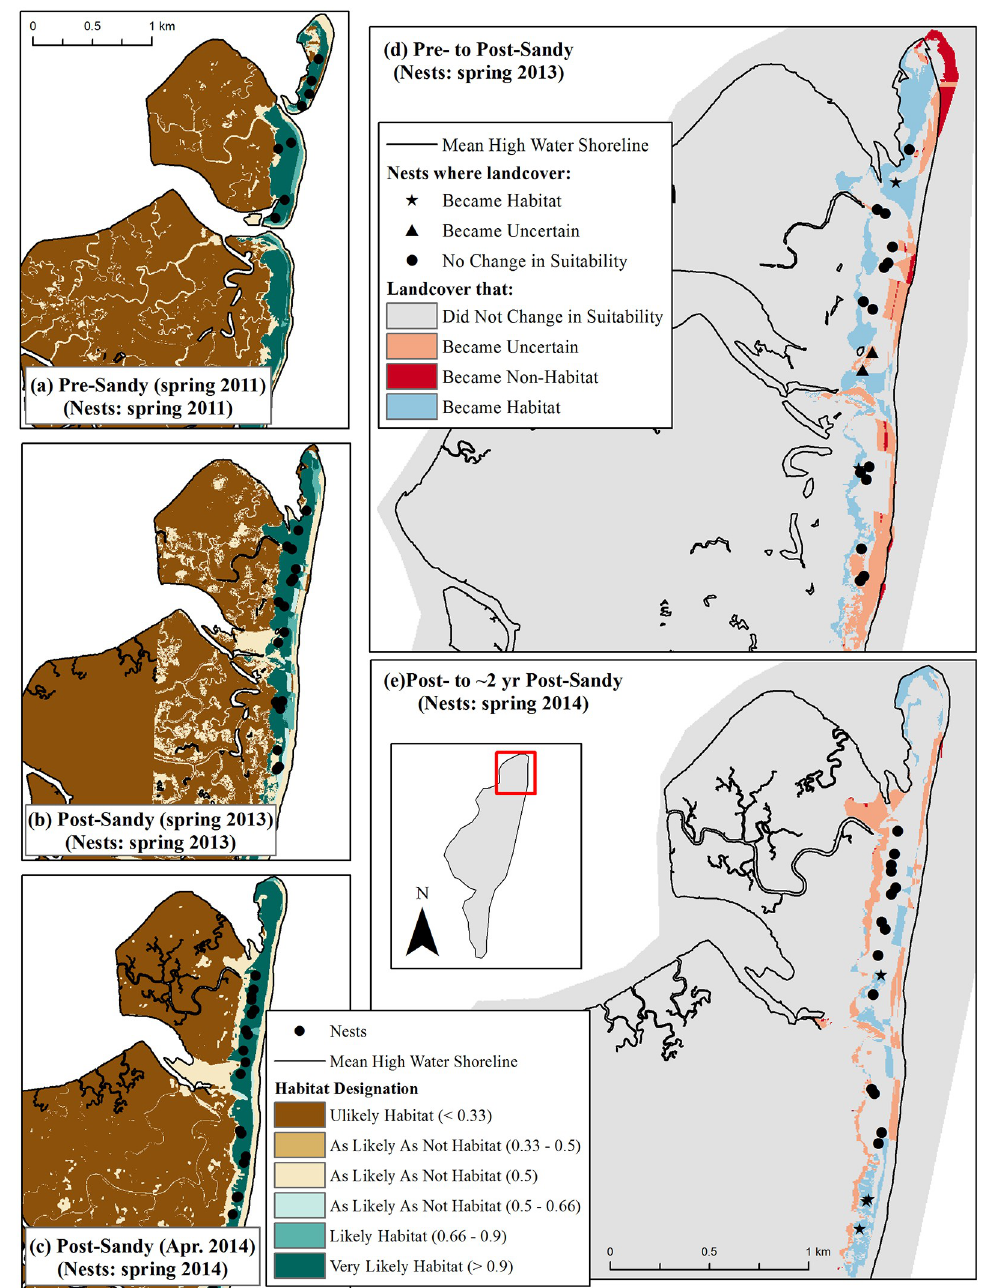
Fig 8. Examples of habitat change before Hurricane Sandy, immediately following Sandy, and ca. 2 years post-Sandy on Cedar Island, Virginia. Maps (a)-(c) show habitat in the year corresponding with the aerial imagery used for analysis, with piping plover nest points corresponding to the breeding season for which habitat was available 1 . Map (d) shows changes in habitat that ostensibly resulted from Hurricane Sandy, while map (e) shows changes in habitat since the hurricane occurred 2 . 1 Nest points contributed by [69]. 2 See footnotes accompanying Fig